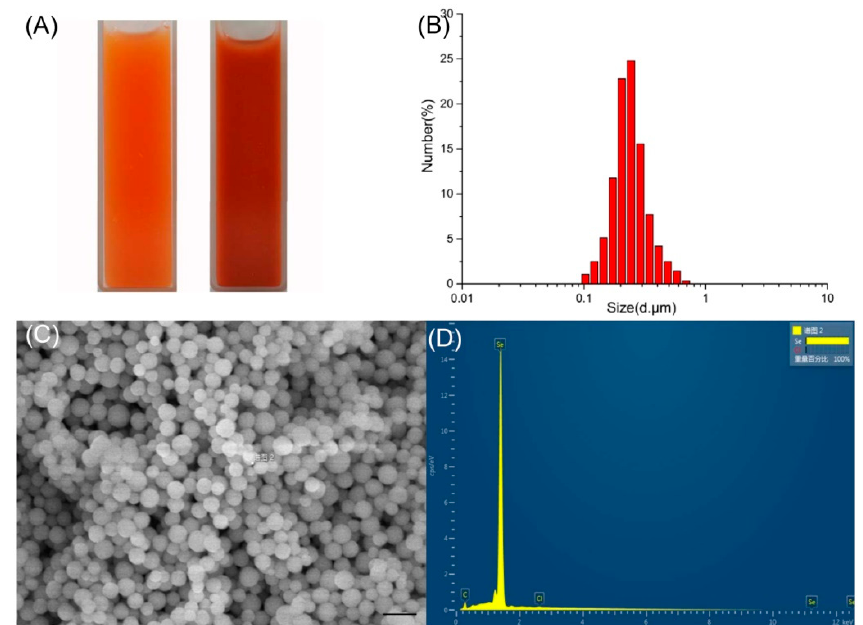
Figure 6. Dynamic Light Scattering (DLS) spectra and SEM-EDX (Energy Dispersive X-ray) analysis of purified SeNPs produced by P. mirabilis YC801 grown with 5.0 mM selenite. ( A ) Selenite-dosing cells (left) and purified nano-selenium (right); ( B ) DLS spectra of purified SeNPs; ( C ) SEM analysis for purified SeNPs; ( D ) EDX spectra for purified SeNPs. The bar represents 1 μ m.